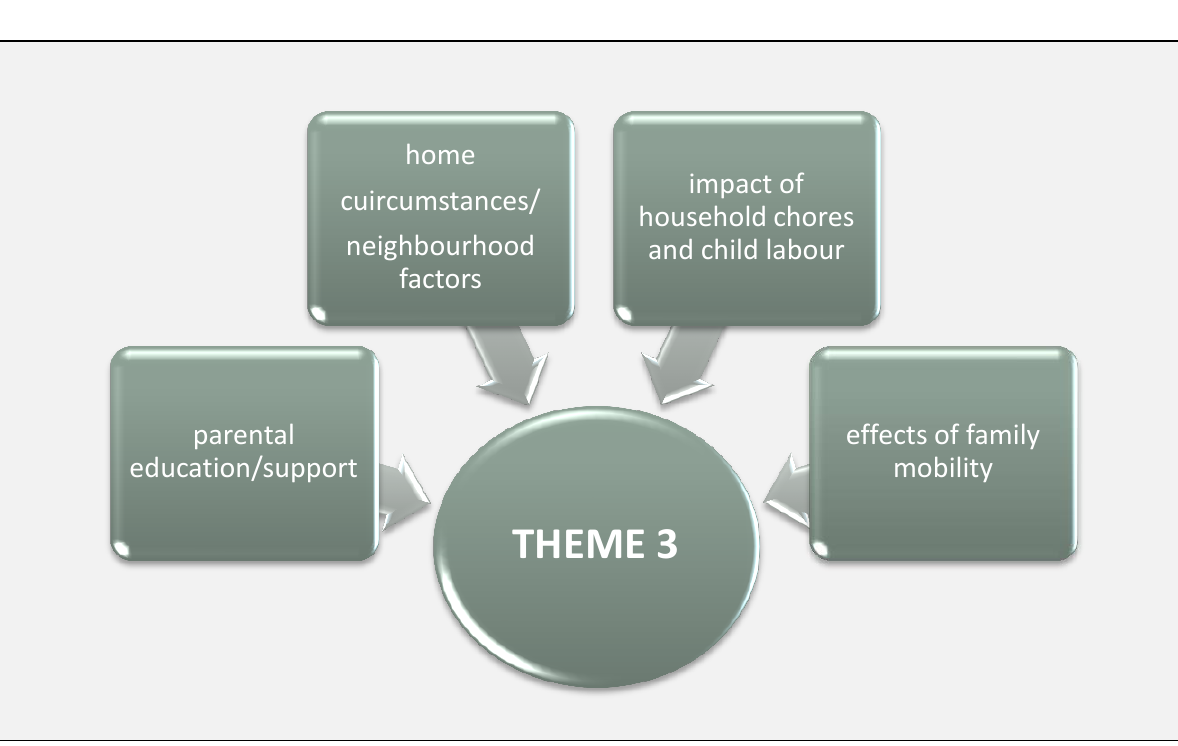
Figure: 5.7 Sub-themes: Home /school/physical environment (Field data,